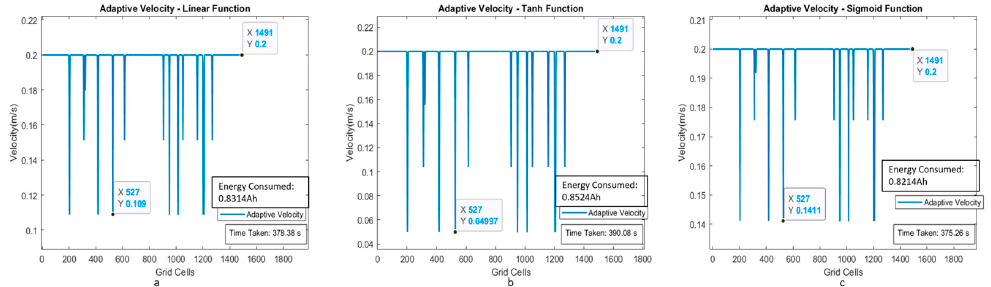
Figure 14. Adaptive velocity behavior model with linear, tanh, and sigmoid functions with a velocity corresponding to the map’s grid cells for scenario